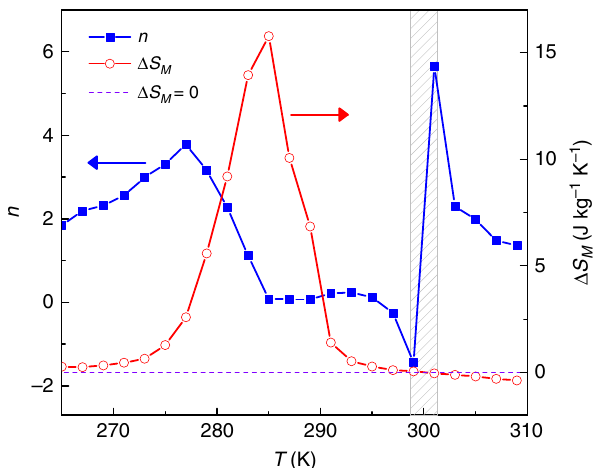
Fig. 7 The magnetic entropy change and its fi eld exponent for Heusler-type alloy. The overshoot of exponent n occurs near the FOPT of Ni – Mn – In – Co Heusler alloy. Characteristic spikes shown in the shaded gray region indicate the switching of inverse to conventional MCE. The maximum applied fi eld was 1.5 T